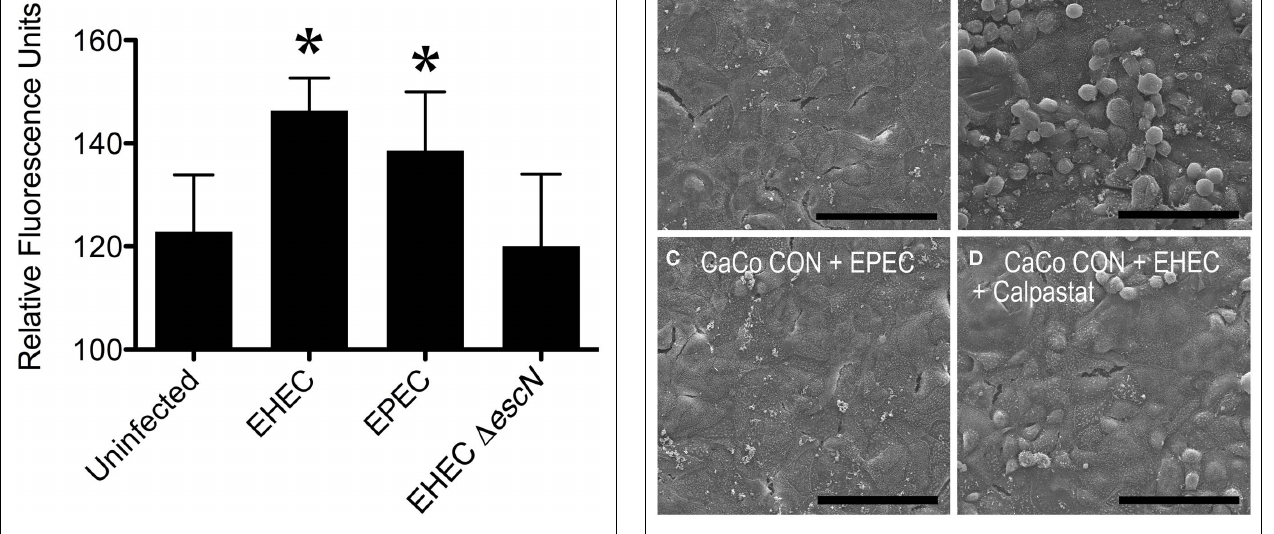
FIGURE 1 | Enterohemorrhagic Escherichia coli increased calpain activity during infection. Calpain activity was measured with a fluorogenic, calpain-specific substrates in lysates of uninfected CaCo-2a cells, or of cells infected with EHEC, EPEC and EHEC Δ escN for 3h. Shown are the means ( ± SE) with (*) indicating significance of p < 0.05 by student’s T -test compared against the uninfected group.